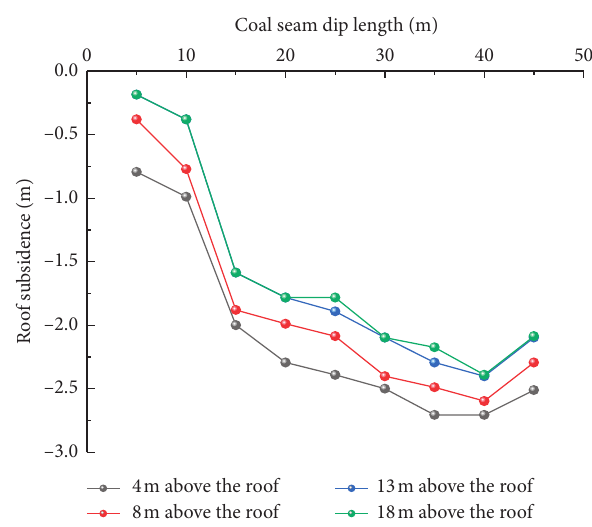
Figure 6: Roof displacement monitoring